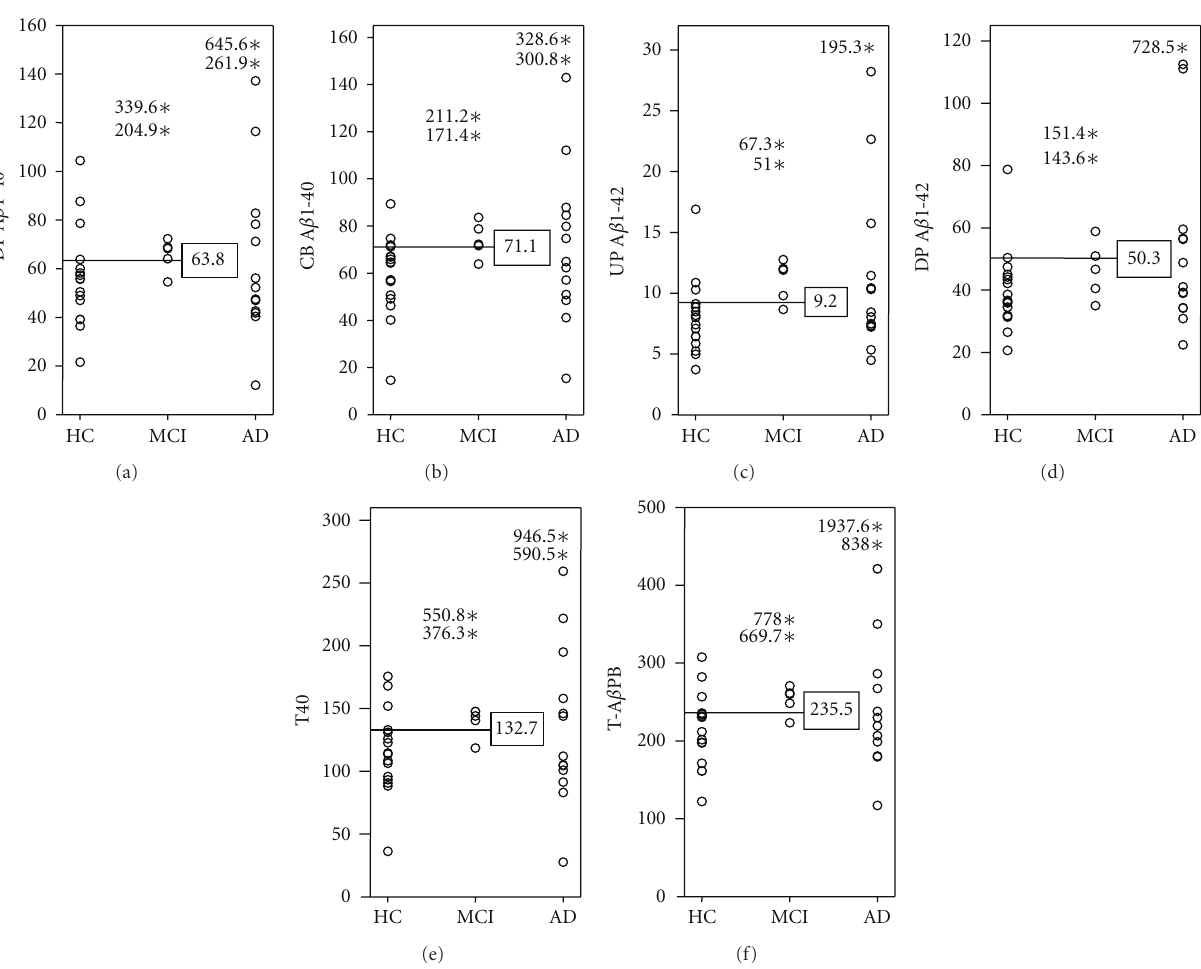
Figure 2: ((a)–(f)). Dot-plot for (a) DP A β 1-40, (b) CB A β 1-40, (c) UP A β 1-42, (d) DP A β 1-42, (e) T40 and (f) T- β APB values in HC, MCI and AD participants. Numbers beside ∗ indicate the value of outliers in the MCI and AD groups, which, for clarity of representation, are not represented at the same scale of the ordinate axis. The horizontal line with the number in parentheses represents the cut-o ff value between MCI and